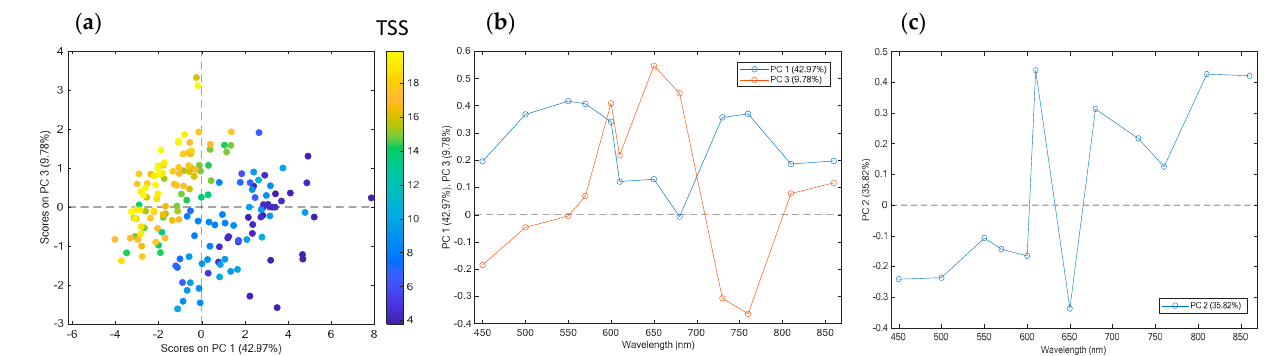
Figure 4. ( a ) Scores plot of PC1 and PC3, labelled according to TSS content and relative loadings plot; ( b , c ) loadings plot of PC2.